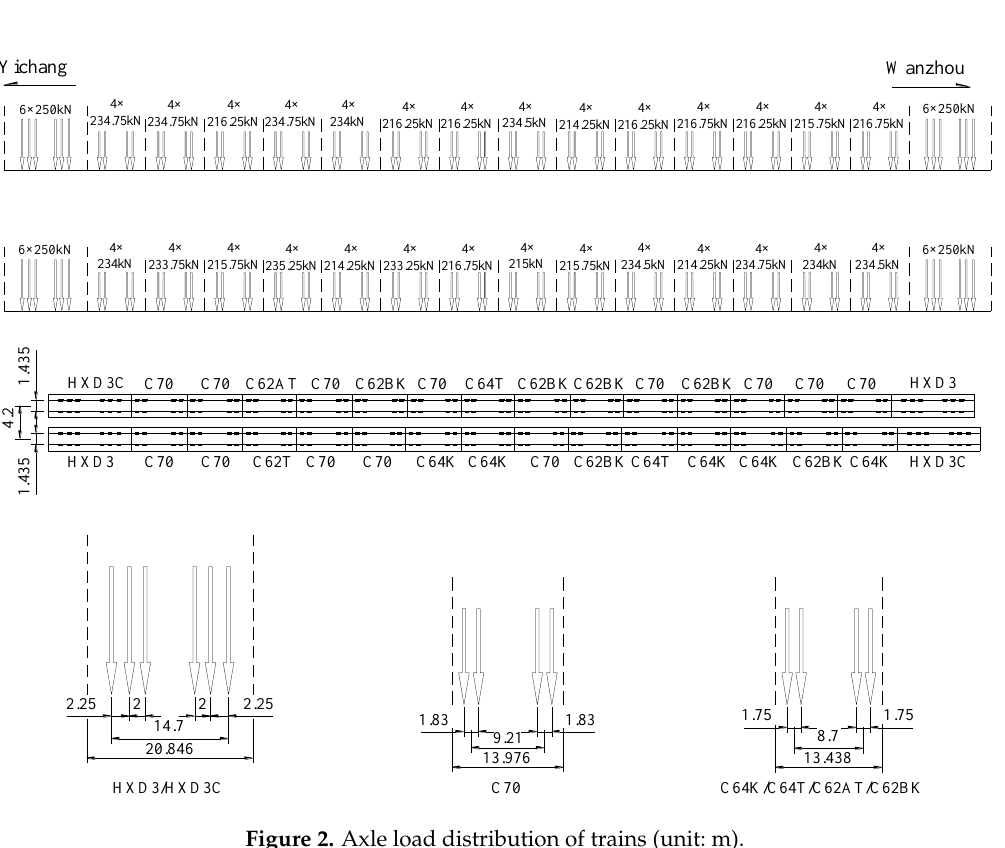
Figure 2. Axle load distribution of trains (unit: m).